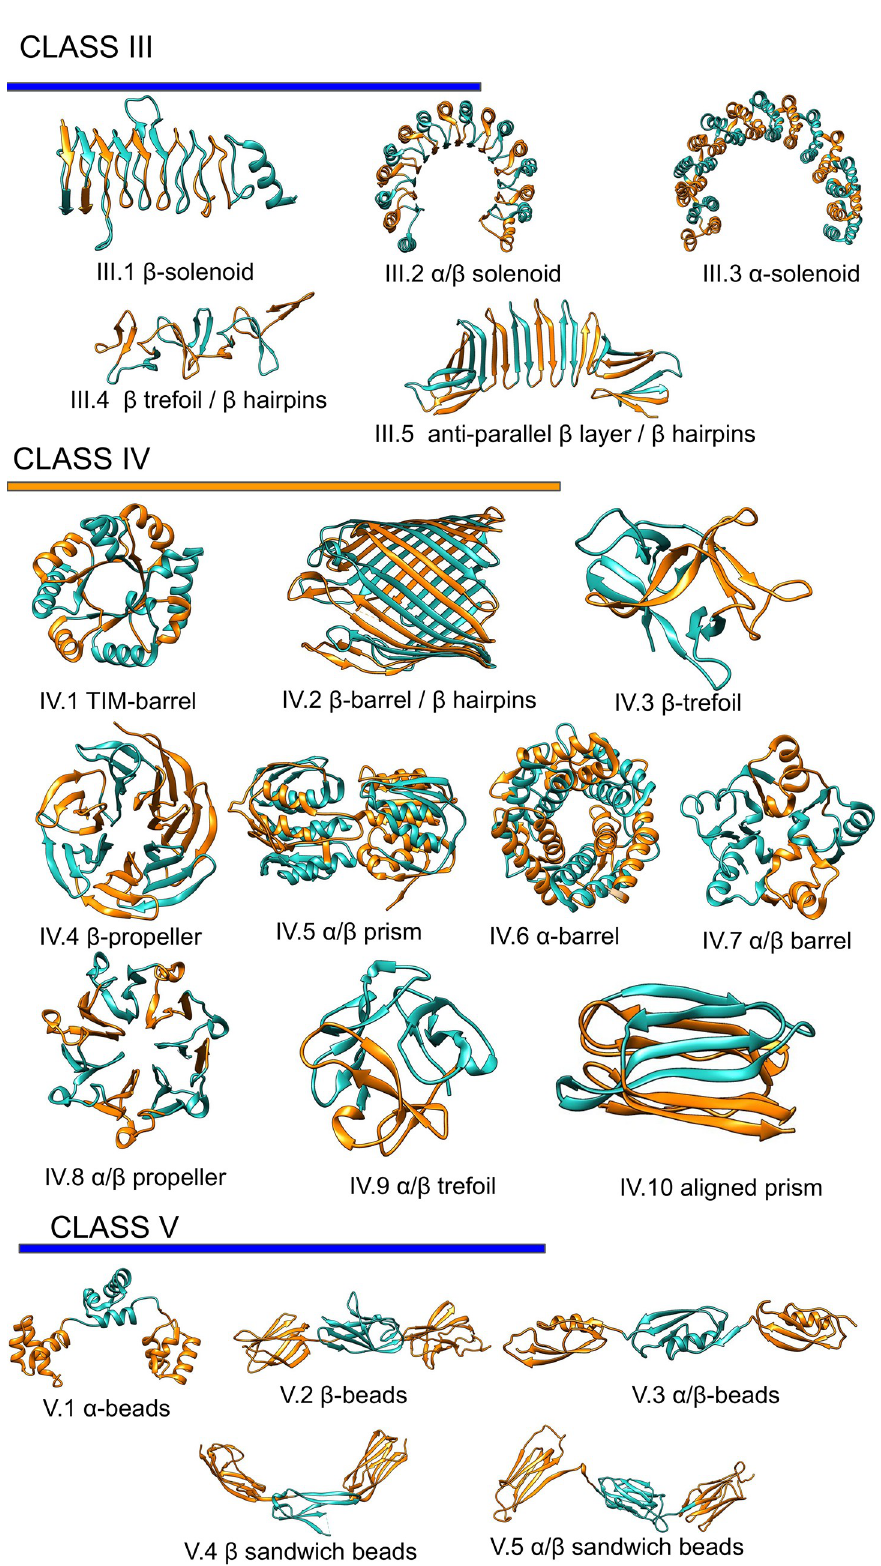
Fig 1. Repeats proteins classification. Representation of the repeats classes and subclasses as classified in repeatsDB 2.0 [14]. https://doi.org/10.1371/journal.pcbi.1008798.g001 PLOS Computational Biology | https://doi.org/10.1371/journal.pcbi.1008798 April 15,